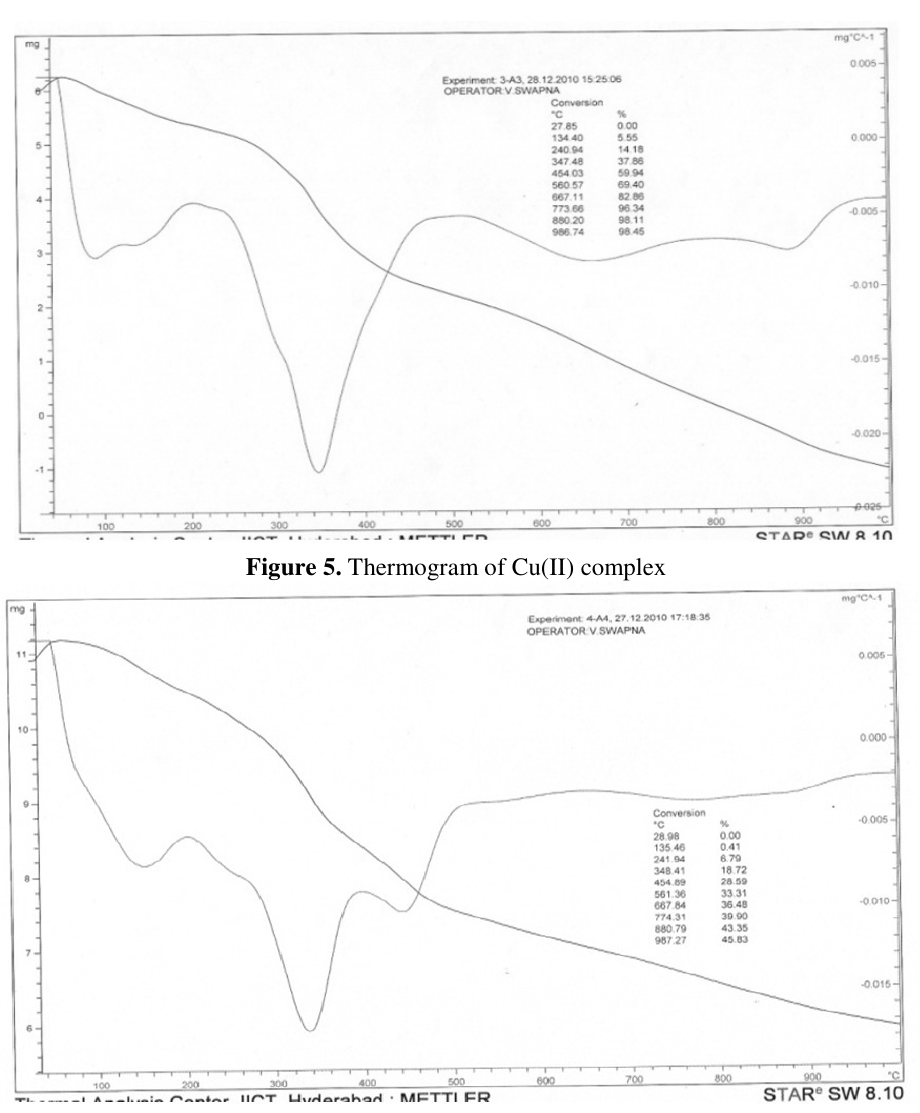
Figure 6. Thermogram of VO(IV)